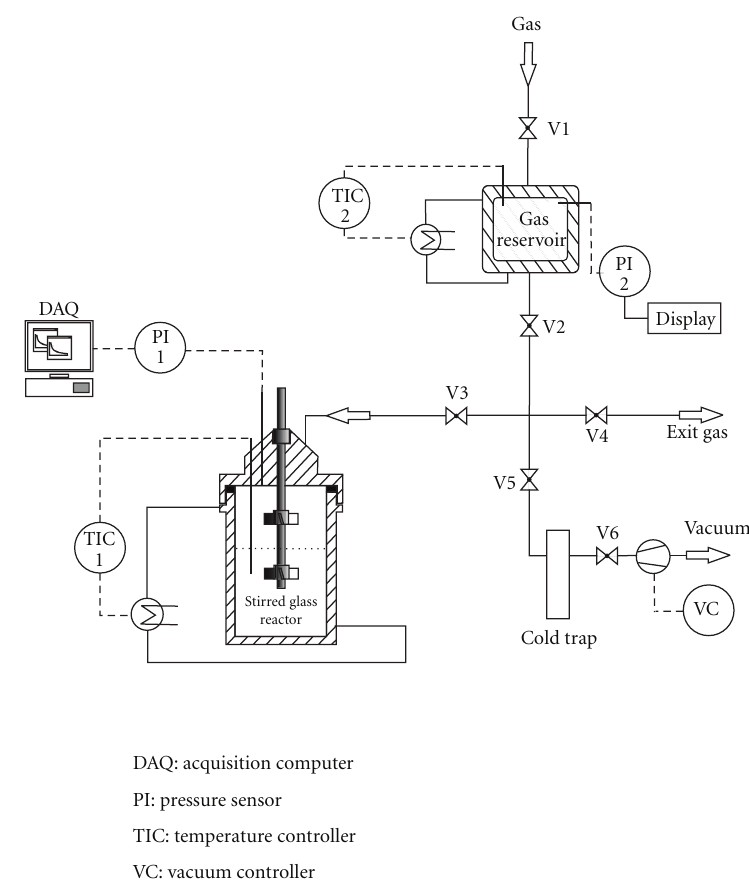
Figure 2: Experimental setup.